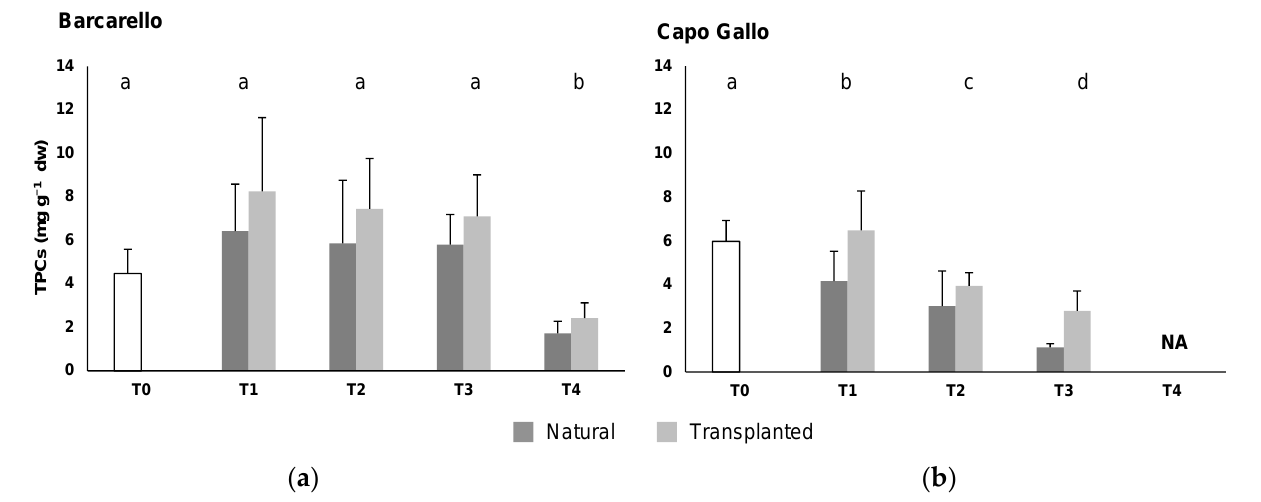
Figure 3. Total phenolic compounds (TPCs; mean ± sd) of Ericaria amentacea at the two sites: ( a ) Barcarello; ( b ) Capo Gallo) across time. Based on pair-wise test results, different letters were attributed to significantly different points.